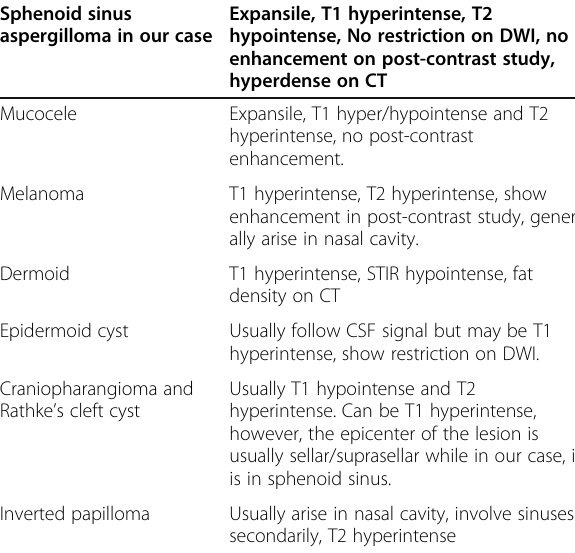
Table 1 Differentials based on T1 hyperintensity of sphenoid sinus [7 –